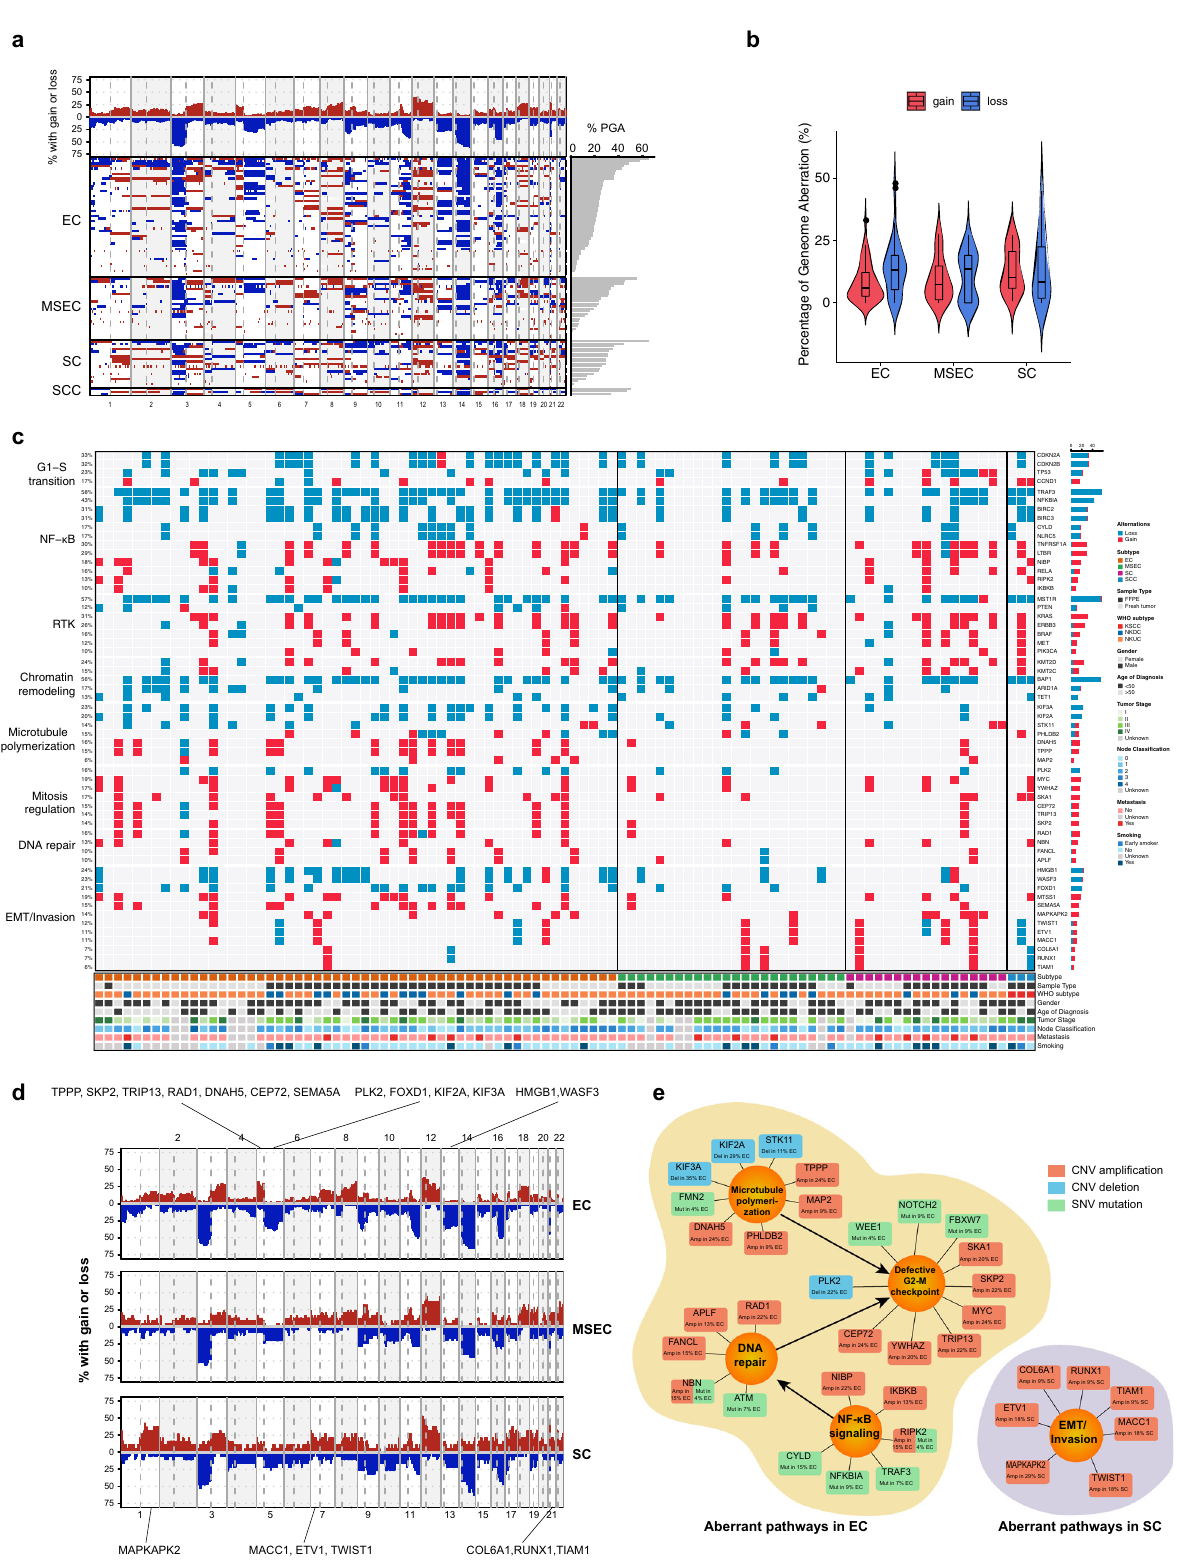
subtype-speci fi c driver mechanisms (Fig. 2e).